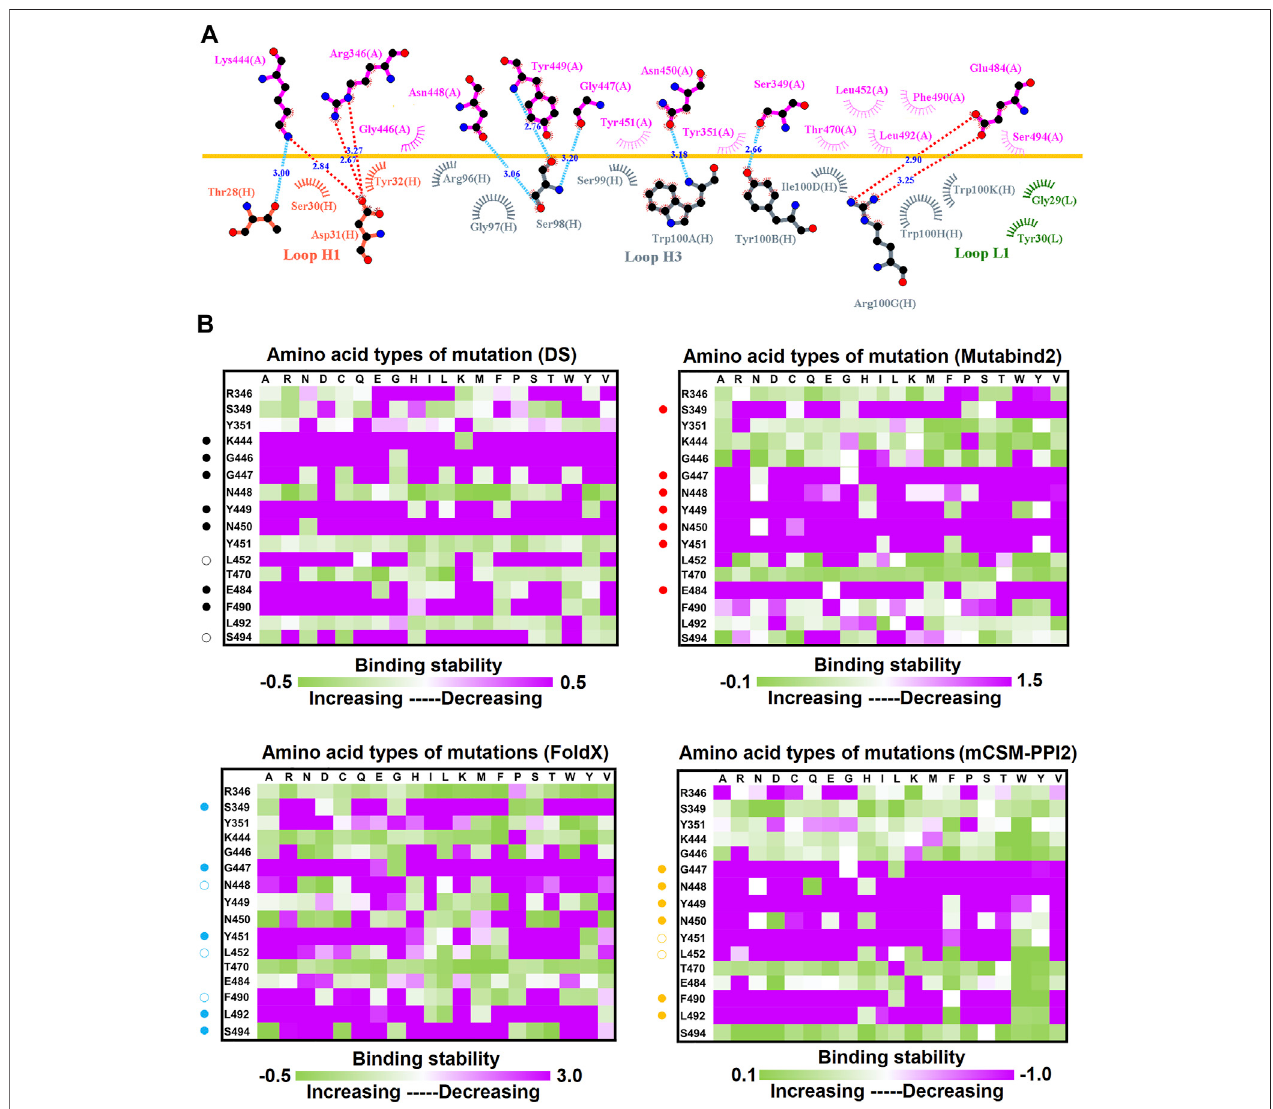
FIGURE2| MutationalheatmapsoftheRBDtargetingantibodyCV07-270. (A) TheLIGPLOTpresentstheinteractionnetworkbetweenCV07-270andtheSARS- CoV-2 RBD. The RBD and lightand heavy chains ofCV07-270 are labeled A, H, and L, respectively. The golden yellow line denotes the interface ofthe RBD – CV07-270 complex. The interactive residues of the RBD are labeled and colored magenta. The salt-bridges and hydrogen bonds are indicated by red and cyan dashes, and the hydrophobic interactions are represented by arcs with spokes radiating toward the ligand atoms with which they are in contact. (B) The mutational binding stabilities of RBD variants to CV07-270 were estimated using FoldX, MutaBind2, DS 3.5, and mCSM-PPI2. The unit of binding stability was the kcal/mole, with the obtained values employed to create the heatmaps. Green (increased stability) and purple (reduced stability) were used to generate a color gradient and were applied in each box. In each heatmap, the moderately and signi fi cantly reduced stabilities were labeled with hollow and solid circles, respectively.